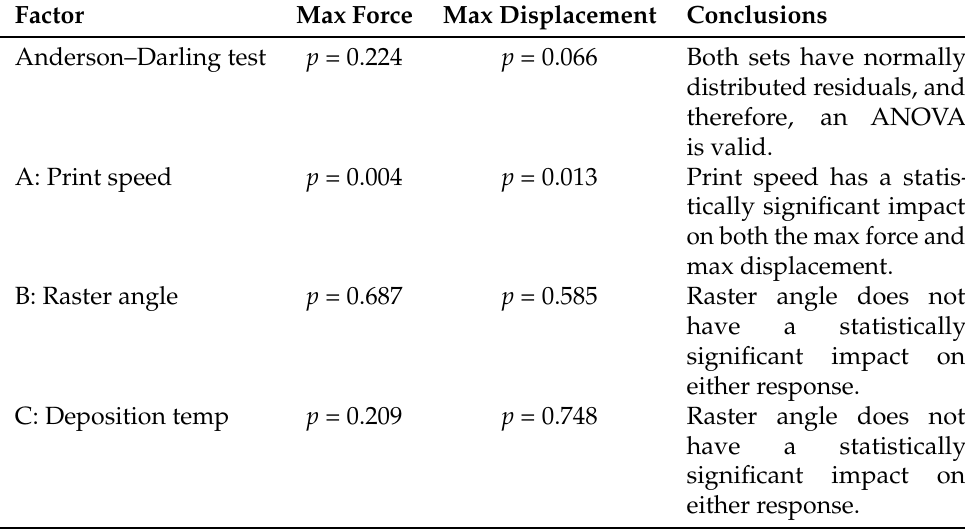
Table 4. Results from the statistical analysis. p-values based on ANOVA with optimal Box–Cox transformation using λ = 6 (calculated by Minitab). Level of significance α =